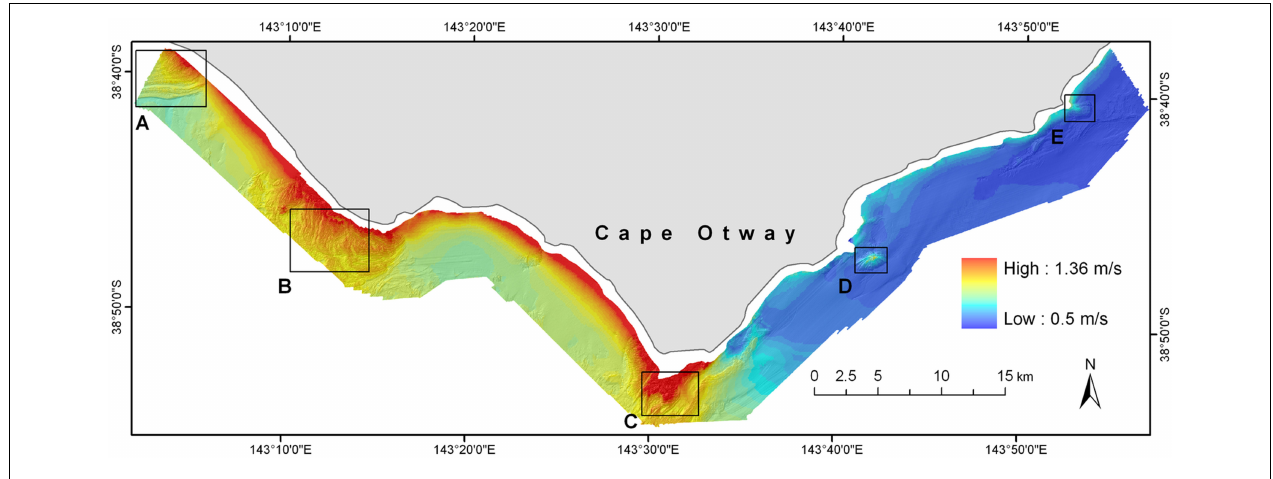
FIGURE 5 | Distribution of modeled maximum orbital velocity (u max ) values across the Cape Otway study site for the year 2000. Maximum bottom orbital velocities were calculated by extending outputs of the local